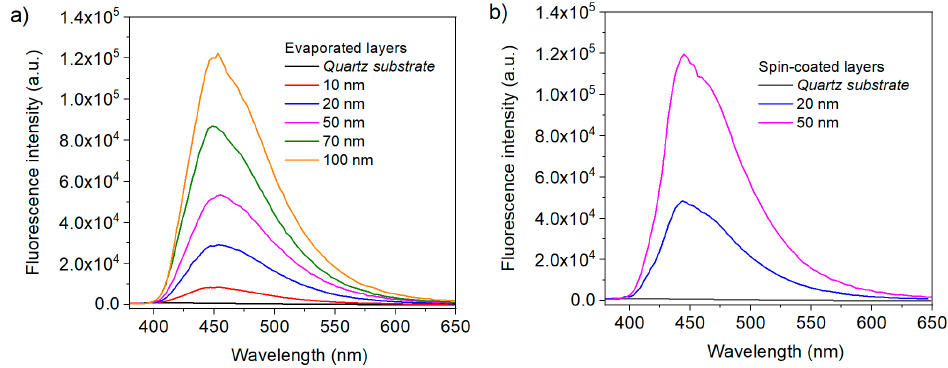
Figure 3. Fluorescence of heptazine layers deposited on quartz, in function of the measured thickness. ( a ) Evaporated layers and ( b ) spin-coated layers. Table 1. QY of the deposited layers as a function of layer